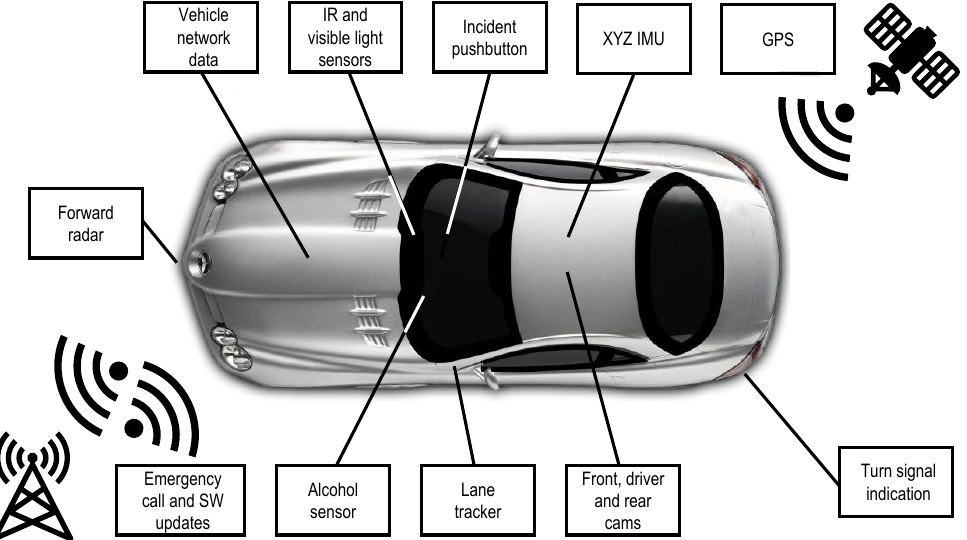
Figure 3. Data acquisition systems and sensors installed in the vehicles that participated in the SHRP2-NDS. IR: infrared; SW: